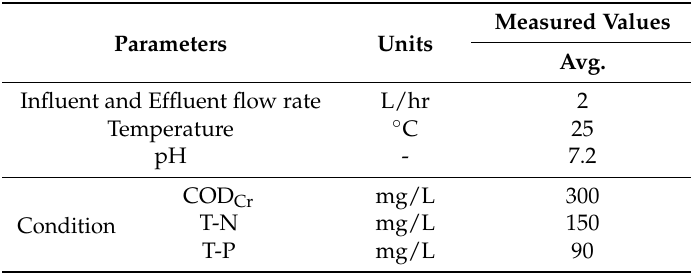
Table 1. Characteristics of the artificial